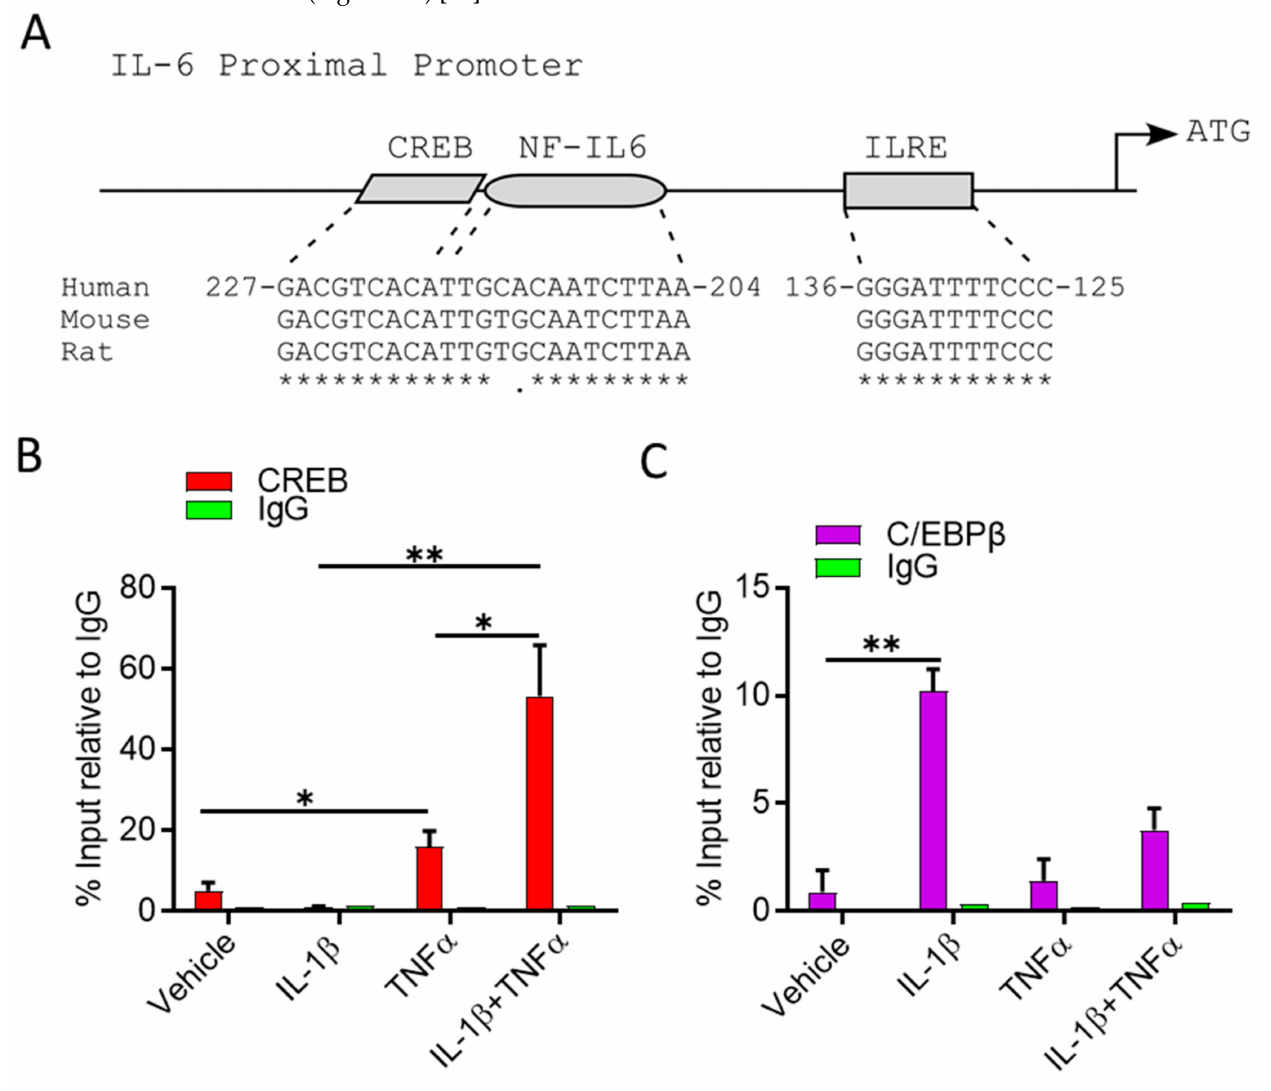
Figure 3. Combined treatment of IL-1 β and TNF α increases CREB binding at IL-6 promoter. ( A ) IL-6 promoter contains an adjacent CREB and C/EBP β binding sites. Chromatin from adipocytes treated with IL-1 β , TNF α alone or in combination was subjected to ChIP with antibodies against ( B ) CREB or ( C ) C/EBP β followed by qRT-PCR. CREB or C/EBP β occupancy at IL-6 promoter was determined. Data are expressed as mean ± SEM ( n = 3). * p < 0.05, ** p <